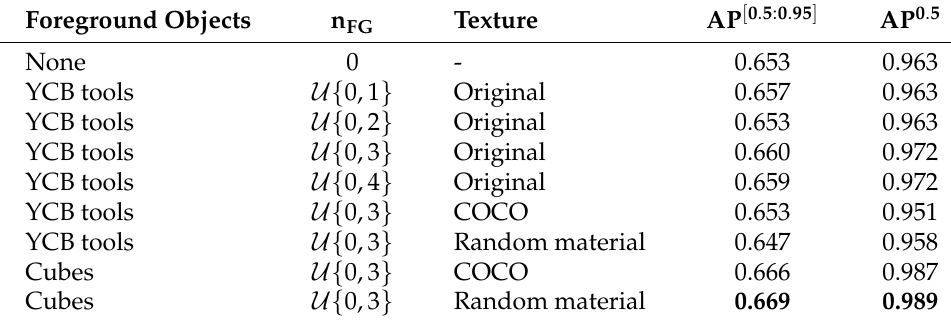
Table 6. Results for additional foreground